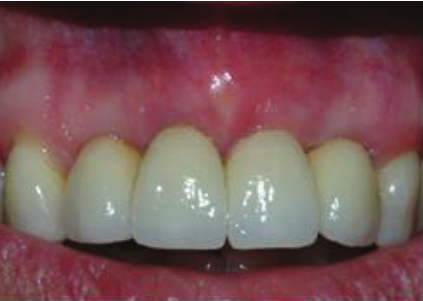
Figure 16: Image showing soft tissues after tissue grafting.